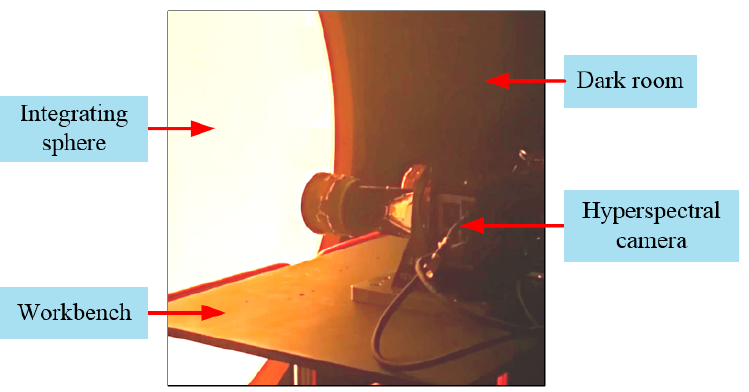
Figure 6. Experimental diagram of radiation calibration.